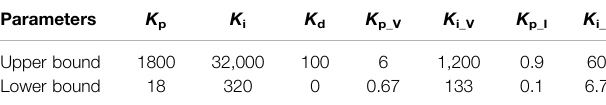
TABLE 2 | Upper bound and lower bound of optimized